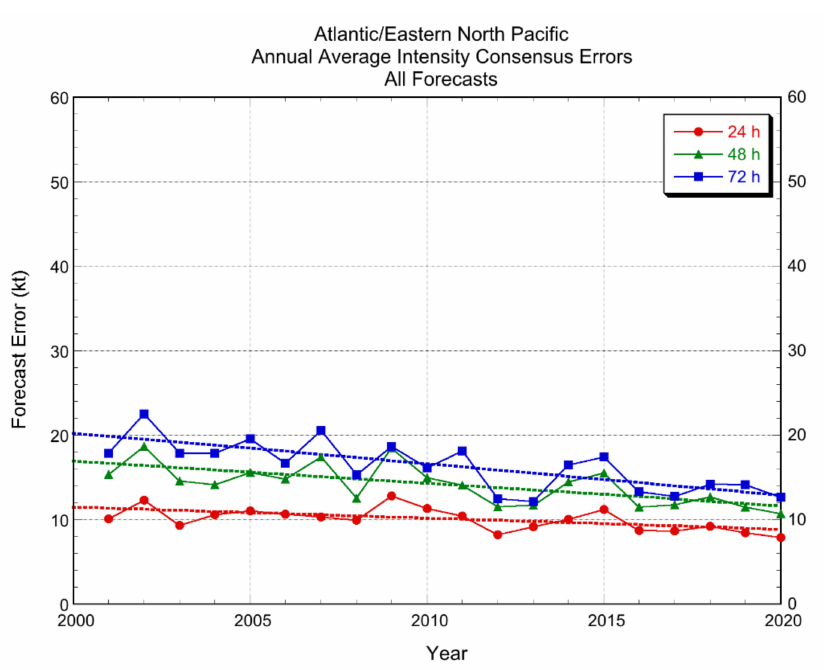
Figure 14. Historical annual average performance of IVCN at 24, 48, and 72 h for the combined Atlantic and eastern North Pacific basins for all forecasts. Least-squares trend lines are shown by dashed lines. Note that the verifications for the 2020 season are preliminary as not all of NHC’s post-storm best track analyses were complete at the time this manuscript was